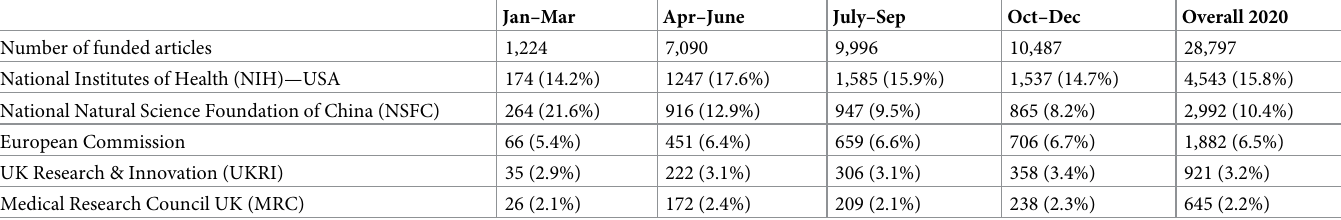
Table 4. Major funders of COVID-19 research in